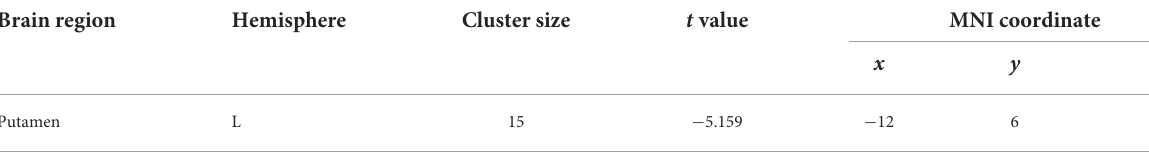
MDD,MajorDepressiveDisorder;MNI,MontrealNeurologicalInstitute.